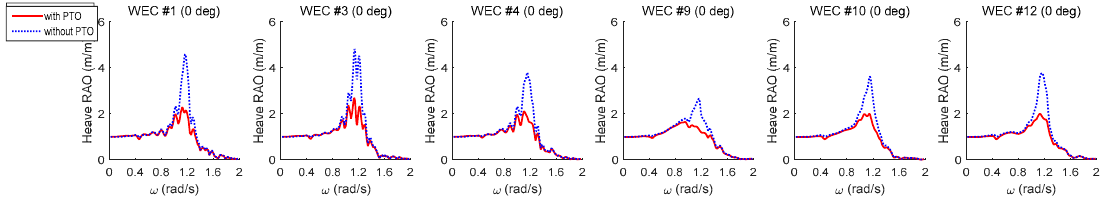
Figure 12. Heave RAO of WEC in array compared to heave RAO of the single WEC in the case of 22.5 deg wave-heading angle.